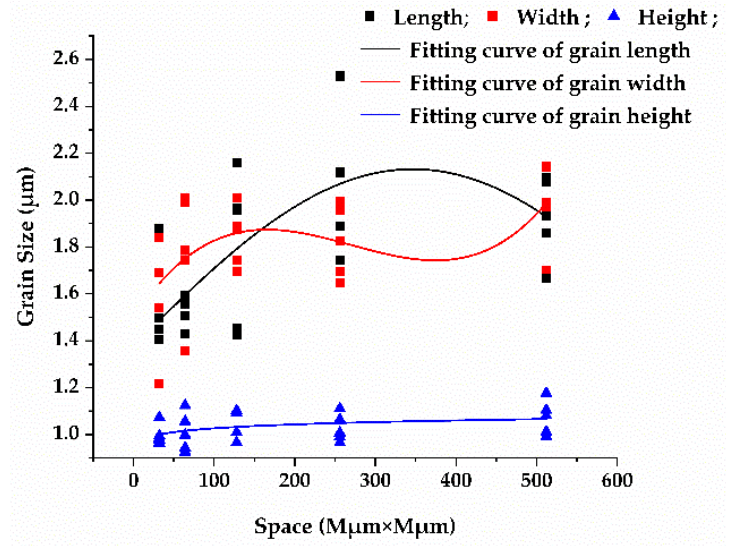
Figure 6. Effect of reaction space on grain size. The length of abrasive grains was distributed in the range of 1.4 µ m–2.5 µ m, and the majority of them were around 1.6 µ m in length. The fitted equation for the width of (cid:1) (cid:1) (cid:0) (cid:0) (cid:1) (cid:0) x 2 + x 3 y = 1.49641 + 0.005353 x − 2.87169 × 10 − 8 abrasive grains is 2.32695 × 10 − 5 , indicating that the width of abrasive grains was oscillating upward as the reaction space increased. The width of abrasive grains was concentrated in the range of 1.6 µ m–2.0 µ m, mainly fluctuating around 1.8 µ m. The fitted equation for the height of abrasive grains is y = 0.92249 x 0.02321 . The fitted image shows that the distribution of height was more concentrated and uniform compared to the length and width of abrasive grains. As the reaction space enlarged, the height of the abrasive grains increased, distributed